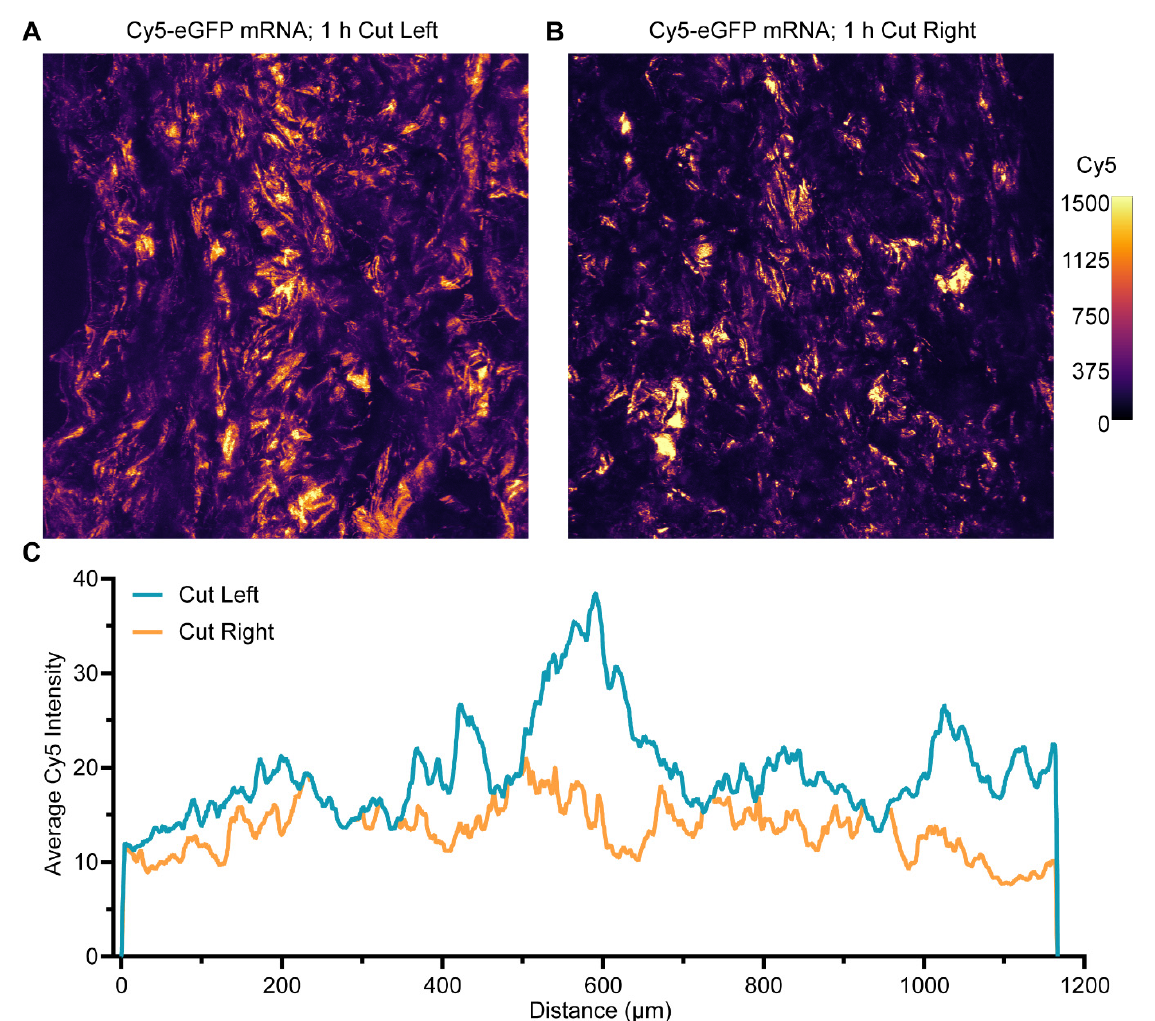
Figure 1. Distribution of peptide-mRNA nanoparticles throughout three-dimensional collagen scaffolds post-lyophilization. PF14-Cy5-eGFP mRNA NPs (214 ng mRNA/scaffold) were loaded onto collagen scaffolds and allowed to diffuse for 1 h, followed by lyophilization, re-swelling, and cutting of orthogonal slices. ( A ) Average Z-projection of 5 confocal sections spanning the entire depth of the cut slice of the scaffold, cutting direction is equal to mRNA NP loading direction. ( B ) Average Z-projection of 3 confocal sections spanning the entire depth of the cut slice of the scaffold, cutting direction is opposite to mRNA NP loading direction. Cy5 intensities are represented by a false-color look-up table (right), and brightness and contrast were equally adjusted across conditions. ( C ) Average Cy5 intensity profiles were measured in Z-projections of ( A ; blue) and ( B ; orange).